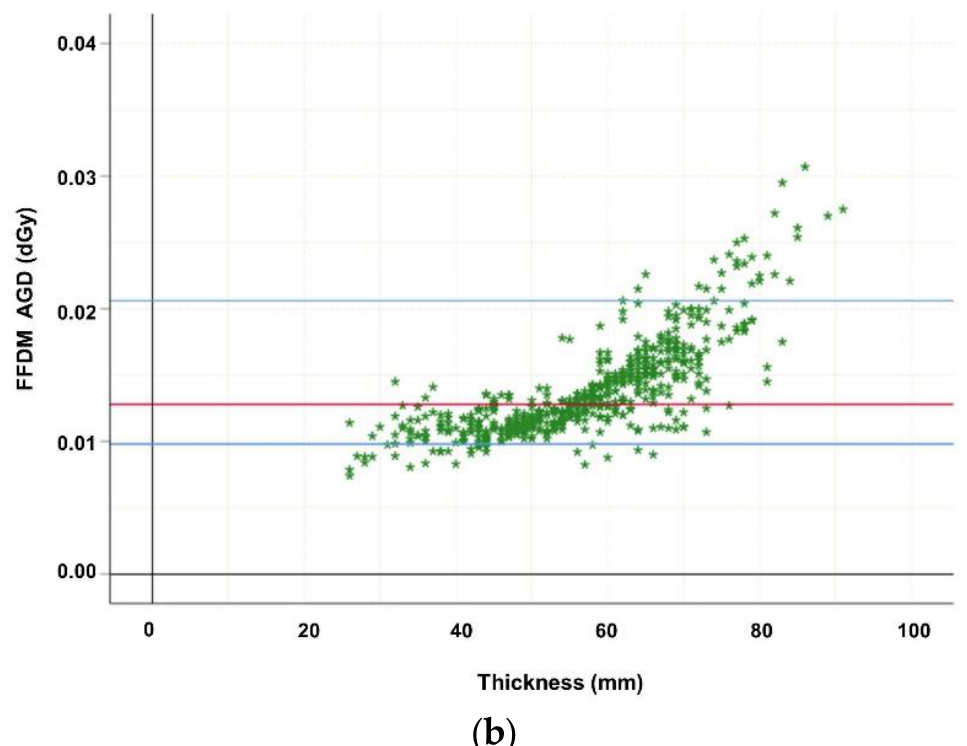
Figure 1. ( a ) Highlighting dependence of average glandular dose (in dGy) of digital breast tomosynthesis (DBT MLO projections; n = 192) on thickness. The MGD increase may be explained mainly by the automatic exposure control (AEC) which influences tube loading, kV, anode/filter combination, and breast composition such as thickness. Red line marks median MGD, the upper blue line marks the 95th percentile, while the lower blue line marks the 5th percentile. ( b ) Highlighting dependence of average glandular dose (in dGy) of digital mammography (FFDM cc and mlo projections; n = 576) on thickness. The MGD increase may be explained mainly by the automatic exposure control (AEC) which influences tube loading, kV, anode/ filter combination, and breast composition such as thickness. Red line marks median MGD, the upper blue line marks the 95th percentile, while the lower blue line marks the 5th percentile.